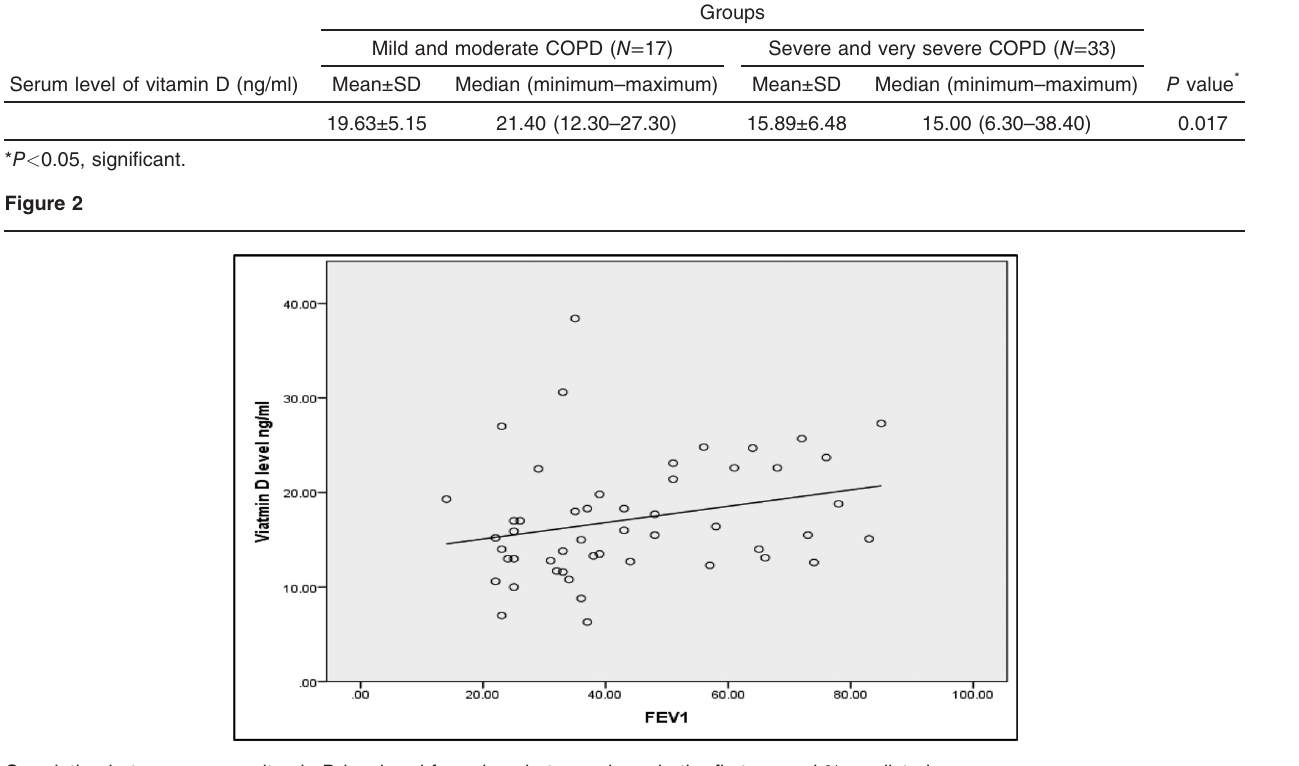
Correlation between serum vitamin D level and forced expiratory volume in the first second